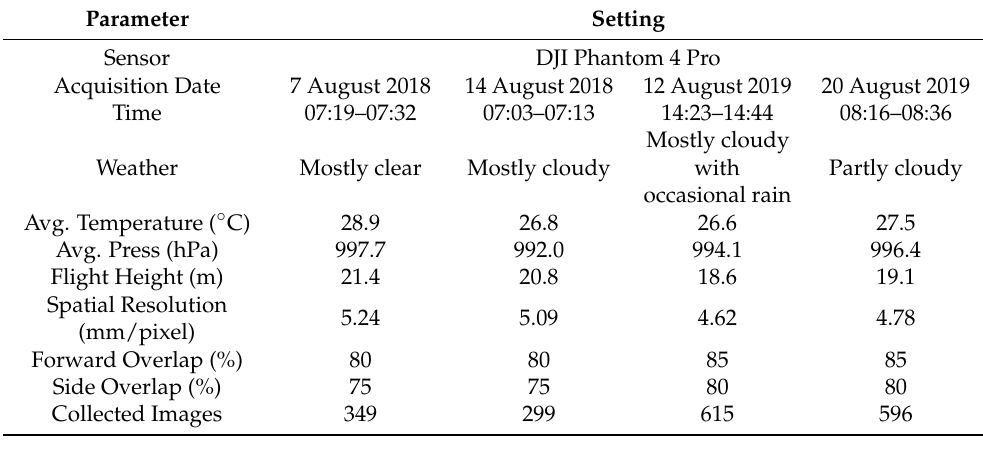
Table 2. Details of flight mission [61].